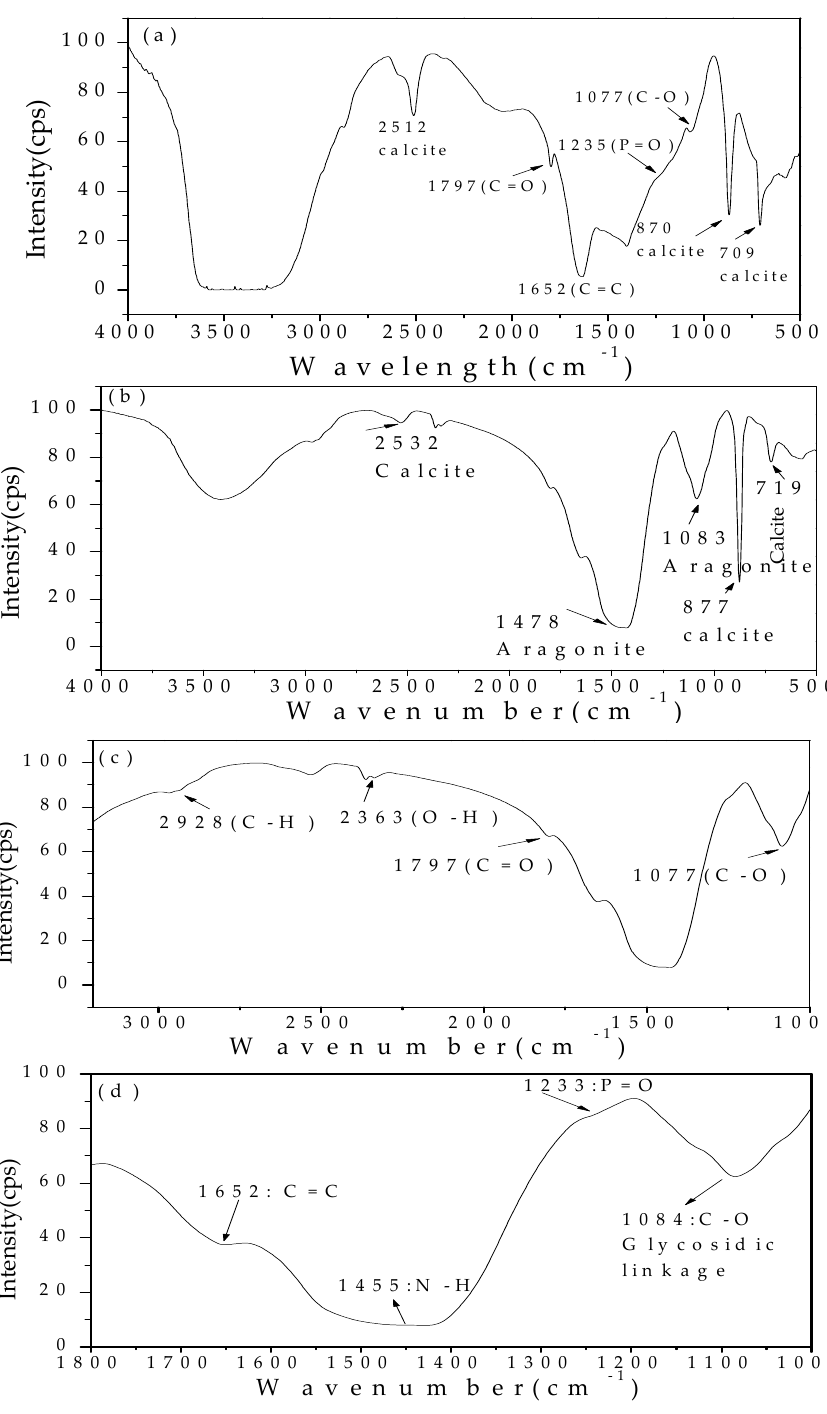
Figure 7. The minerals analyzed by FTIR. ( a ) Calcite at Mg/Ca molar ratio of 0; ( b ) calcite and aragonite at Mg/Ca molar ratio of 3; ( c ) the minerals at Mg/Ca molar ratio of 3 from 1000 to 3200 cm − 1 ; ( d ) the minerals at Mg/Ca molar ratio of 3 from 1000 to 1800 cm − 1 .